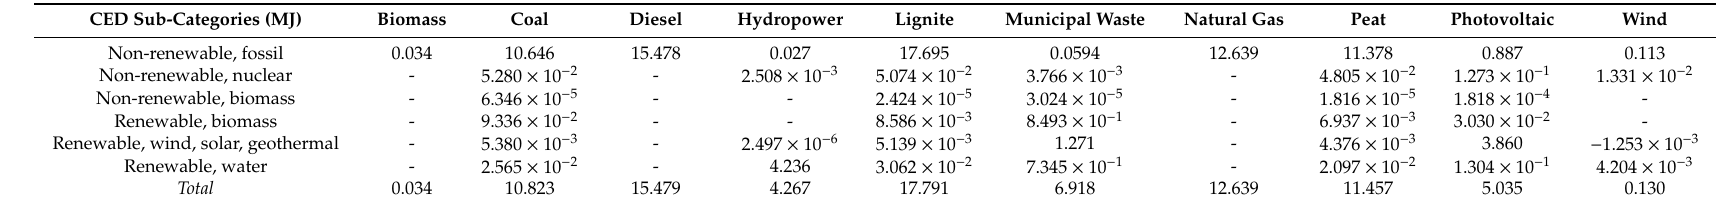
Table 1. Cumulative energy demand results for di ff erent electricity